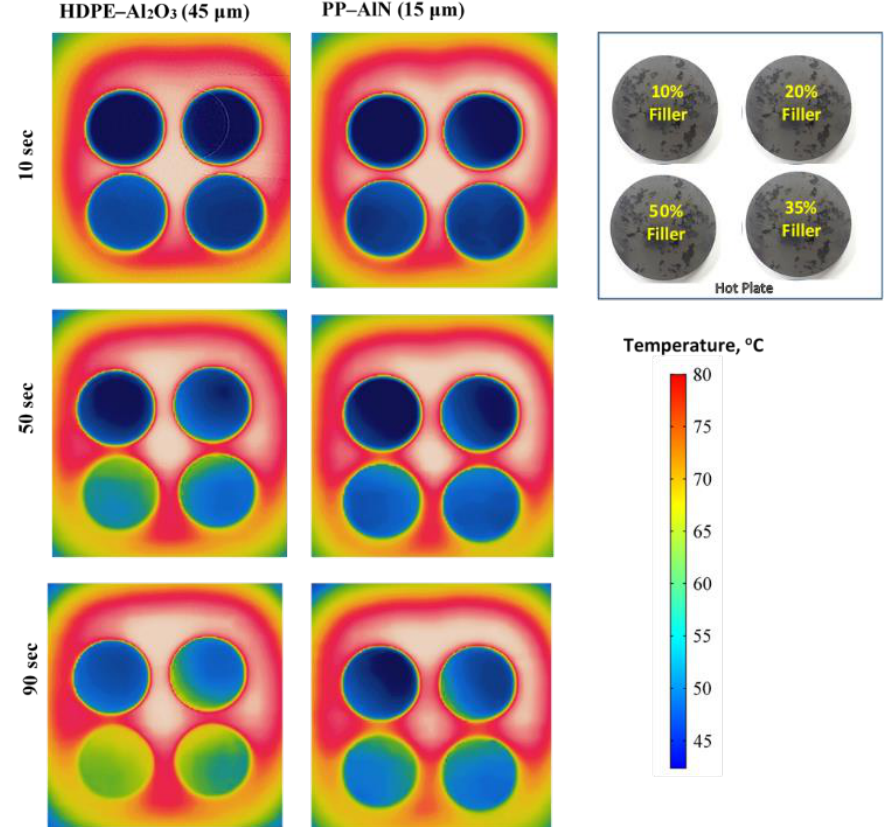
Figure 9. Thermal images of different composites captured as a function of time. HDPE/Al 2 O 3 composites (45 µ m Al 2 O 3 ) with 10, 20, 35, and 50 vol% loading. PP/AlN composites (15 µ m AlN) with 10, 20, 35 and 50 vol%